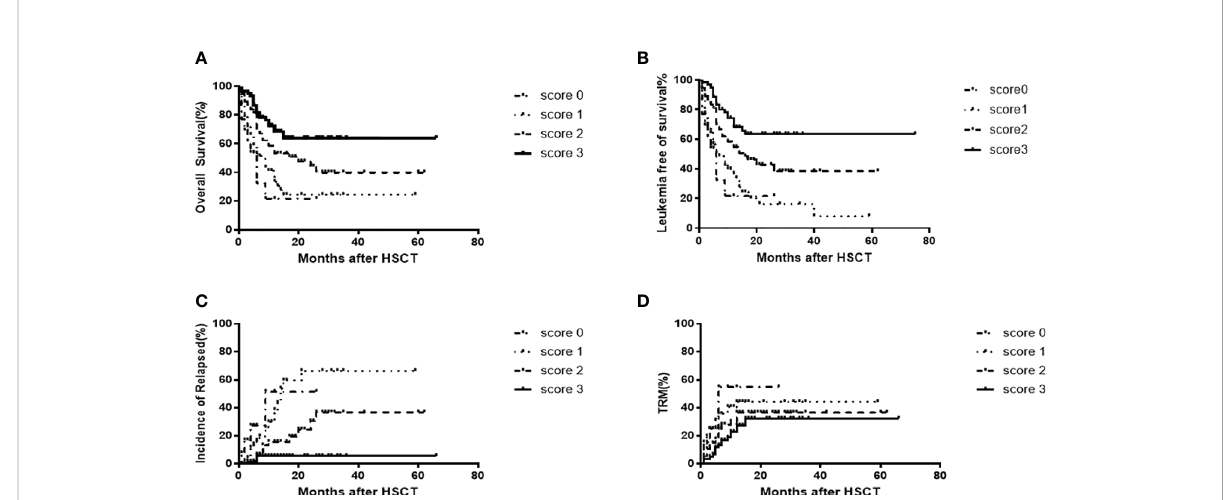
FIGURE 3 OS[score 3(63.3% [95%CI,56.6-70.0]) vs score 2(43.9%[95%CI,36.1-50.5]) vs score 1(24.2% [95%CI,18.4-30.6]6.7%)vs score 0(20.0%[95%CI,8.3- 32.0]),P=0.0001)] (A) and LFS[score3(63.8%[95%CI,56.6-70.0]) vs score 2(43.9%[95%CI,36.6-50.5]) vs score 1(18.3%[95%CI,12.3-24.7]) vs score0 (20.0%[95%CI,8.3-32.0]), P=0.0001] (B) CIR [score 3 (5.5%[95%CI,2.4-8.6]) vs score 2(30.0%[95%CI,21.2-38.8]) vs score 1(65.5%[95%CI,54.6- 76.4]) vs score0(51.5% [95%CI,30.6-73.3]), P=0.0001] (C) and TRM [score 3(32.9%[95%CI,26.2-39.6]) v score2(35.6%[95%CI,29.6-41.6]) vs score1 (40.5%[95%CI,33.9-47.6]) vs score0(55.9%[95%CI,37.1-74.0]), P=0.007] (D) outcomes following allo-HSCT2 among 199 patients, according to prognostic